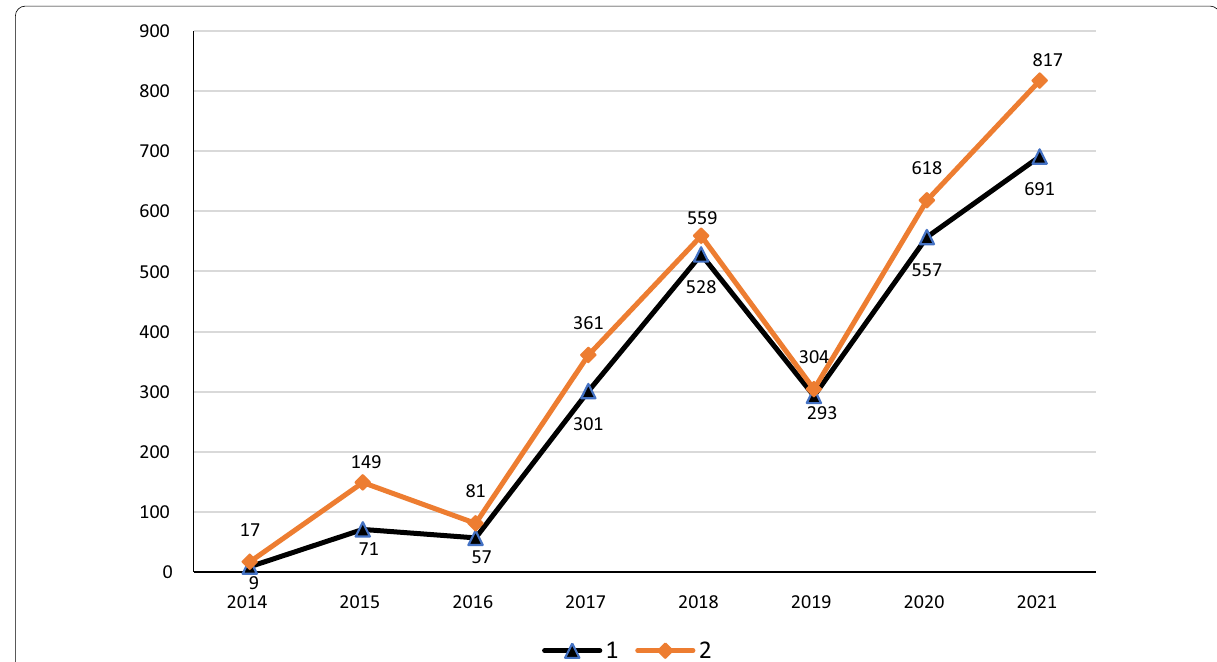
Fig. 4 Numbers of tweets and mentions by calendar year (1 10th, 2022). * The number of article mentions in the social media is provided by Altmetric, which monitors article mentions on Twitter, Facebook, Google , Reddit, Blogs, news outlets and Faculty of 1000 reviews. Articles can only be counted if the DOI is included in the article +